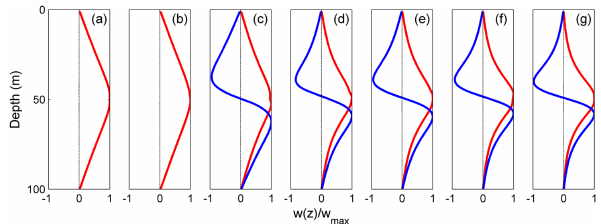
Figure 12. The modal structures on mode-1 (red solid line) and mode-2 (blue solid line) waves in front of the mode-2 ISW at (a) 10 T and (b) 22 T and in the rear of the mode-2 ISW at (c) 4 T , (d) 10 T , (e) 16 T , (f) 22 T and (g) 28 T for the control experiment (case